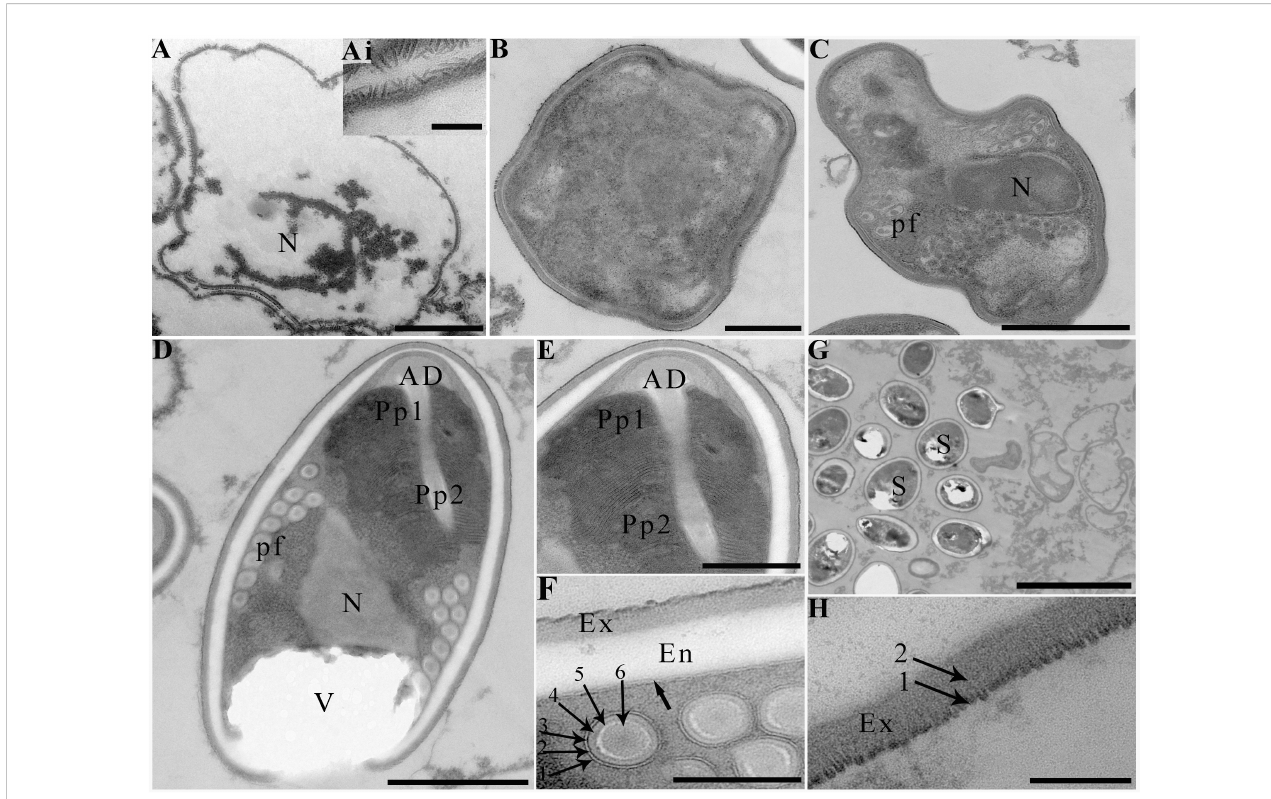
FIGURE 3 Electron microscopy of Neo fl abelliforma dubium n. sp. (A) An early sporoblasts contained a large nucleus, scale bar = 1 m m. (Ai) The magni fi cation of the electron-dense tubular projections on the surface of sporoblasts, scale bar = 500 nm. (B) A sporoblasts with denser cytoplasm, scale bar = 500 nm. (C) A late sporoblasts showed the polar fi laments and an oval nucleus, scale bar = 1 m m. (D) Mature spores contained a mushroom-shaped anchoring disc, iso fi lar polar fi lament, a vacuole, a bipartite polaroplast, a large nucleus, and a trilaminar spore wall, scale bar = 1 m m. (E) The magni fi cation of bipartite polaroplast showing narrow lamellae and wide lamellae, scale bar = 500 nm. (F) Magni fi cation of transverse section of polar fi laments showing six discontinuous concentric circles, spore wall including an electron-dense exospore and an electron-translucent endospore, scale bar = 100 nm. (G) Mature spores residing in direct contact with the host cell cytoplasm, scale bar = 5 m m. (H) Magni fi cation of the exospore showing two distinct layers, scale bar = 100 nm.